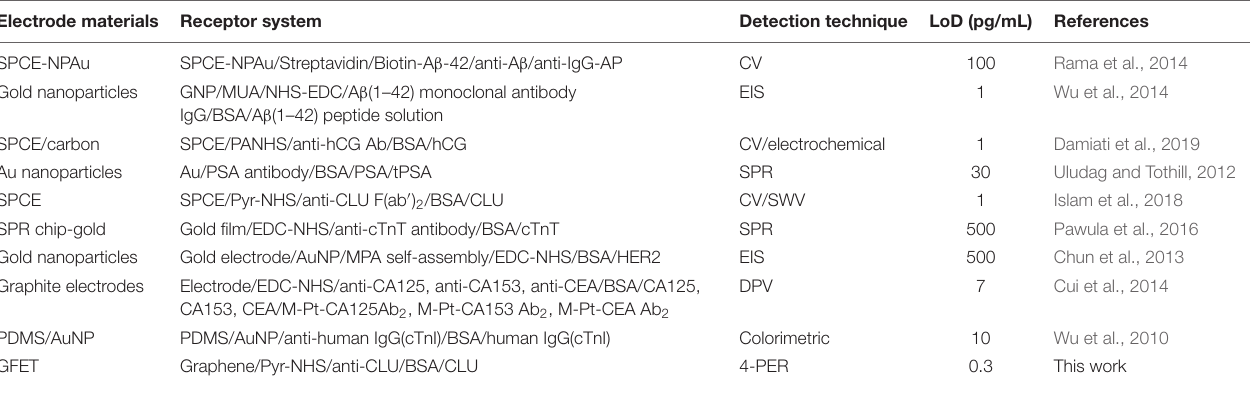
The Clusterin and hCG concentrations are in units of g/mL. TABLE 4 | Other approaches deployed for biosensors in comparison with our GFET based four-probe electrical resistance (4-PER) detection technique. Electrode materials Receptor system Detection technique LoD (pg/mL) References SPCE-NPAu